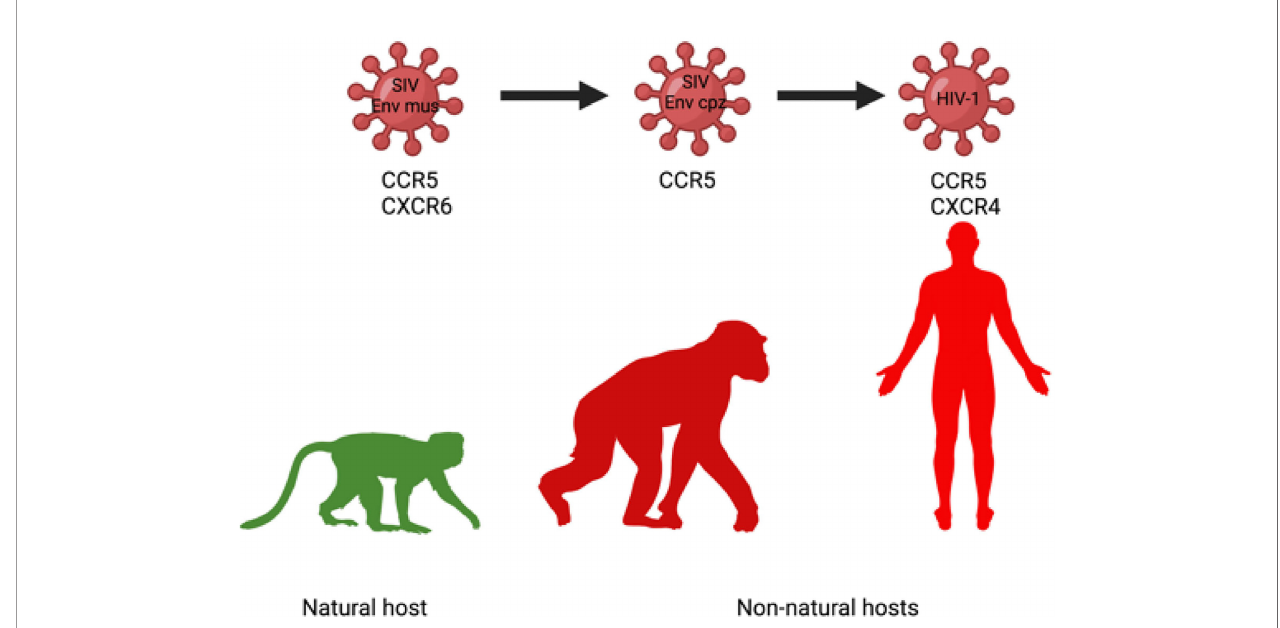
FIGURE 3 | Change of coreceptor tropism (loss of CXCR6 usage) in the SIVcpz/HIV-1 lineage may contribute to increased use of CCR5 as an entry coreceptor, more widespread infection of target cells and enhanced pathogenicity of SIVcpz/HIV-1 in chimpanzee and human, respectively